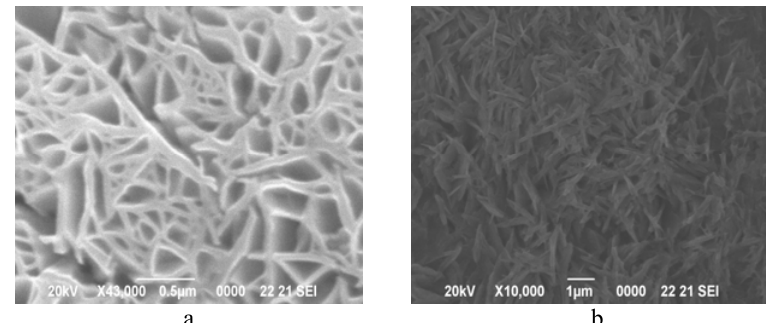
Figure 5. The SEM mild steel specimens: a) 0.1N HCl in the absence of inhibitors; b) 0.1N HCl containing 0.05 M Trisodium citrate and 0.5M sodium benzoate